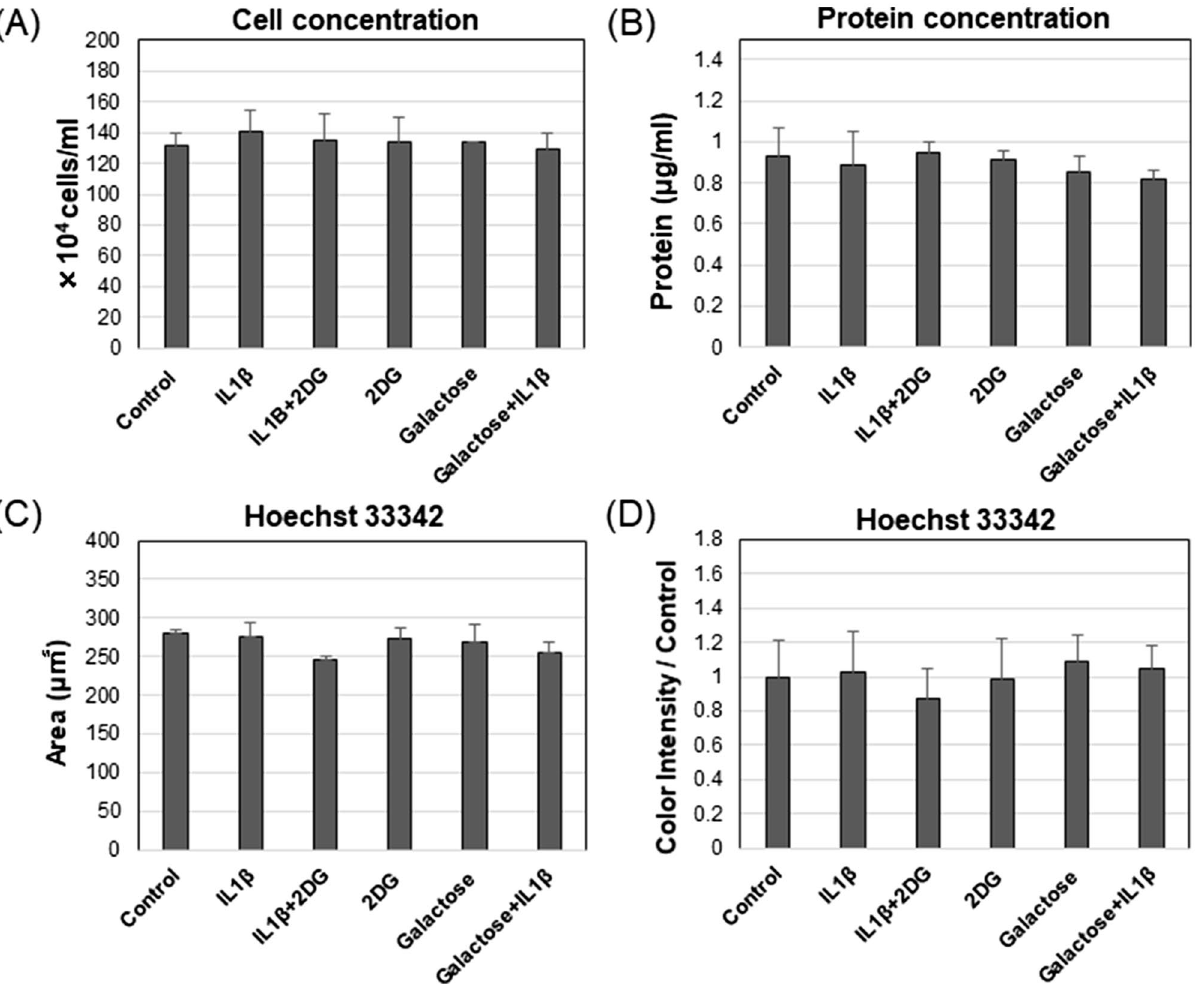
Figure 2. IL1β, 2DG, or galactose culture conditions did not cause any changes to cell proliferation of primary chondrocytes. ( A ) Bar graph of cell number comparing each condition [mean ± S.D. (error bars), n = 4]. ( B ) Bar graph of protein concentration comparing each condition [mean ± S.D. (error bars), n = 4]. ( C ) Bar graph of the total Hoechst 33342-stained cell occupied area [mean ± S.D. (error bars), n = 3]. ( D ) Bar graph of the color intensity of Hoechst 33342 [mean ± S.D. (error bars), n = 3] ANOVA followed by Tukey post-hoc test was used for statistical analysis. *p < 0.05; **p < 0.01. Representative images of brightfield and fluoroscopy are shown in Supplementary Fig.